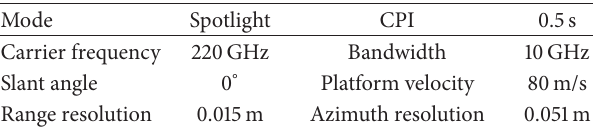
Table 1: THz-SAR